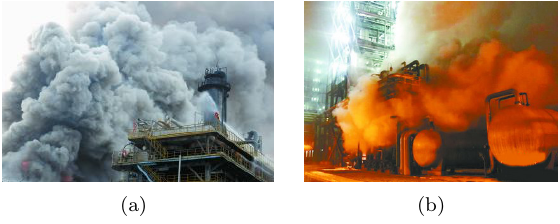
Figure 1. Fire caused by heat exchanger